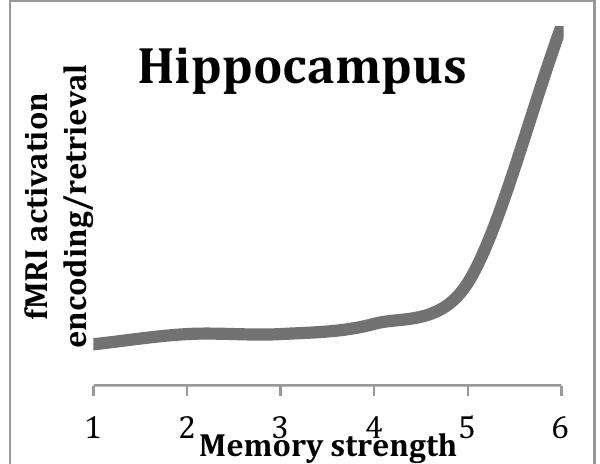
Figure 2. Nonlinear relationship between functional magnetic resonance imaging (fMRI) activation (ordinate) and memory strength (abscissa) in the hippocampus (HPC). The pattern is equal during encoding as well as during retrieval. The memory strength in this example ranges from 1 (weak) to 6 (strong). The figure shows that weak to middle strong (1–5) memories show a constant fMRI activation, where very strong (6) memories are associated with an extremely high fMRI activation in the HPC (according to